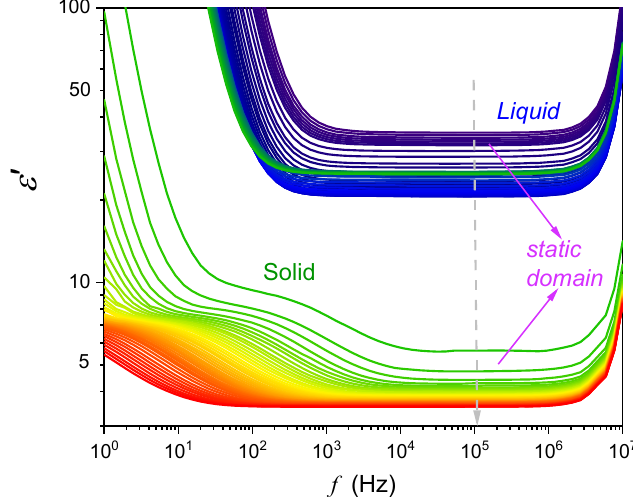
Figure 1. The real part of dielectric permittivity obtained in isothermal pressure measurements at T = 308.2 K. The static domain related to ‘horizontal’, frequency independent, and defining dielectric constant ε (cid:48) ( f ) = ε is indicated. For frequencies below the static domain, the rise is associated with residual ionic contaminations. For frequencies above the static domain, the impact of relaxation processes emerges.